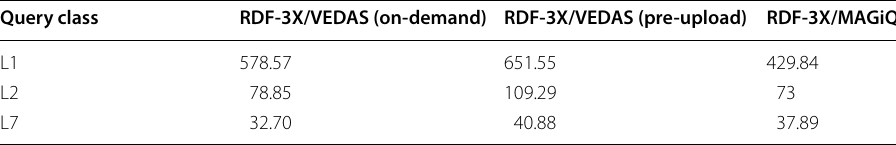
Table 11 LUBM benchmark’s speedup of VEDAS and MAGiQ compared against RDF-3X Query